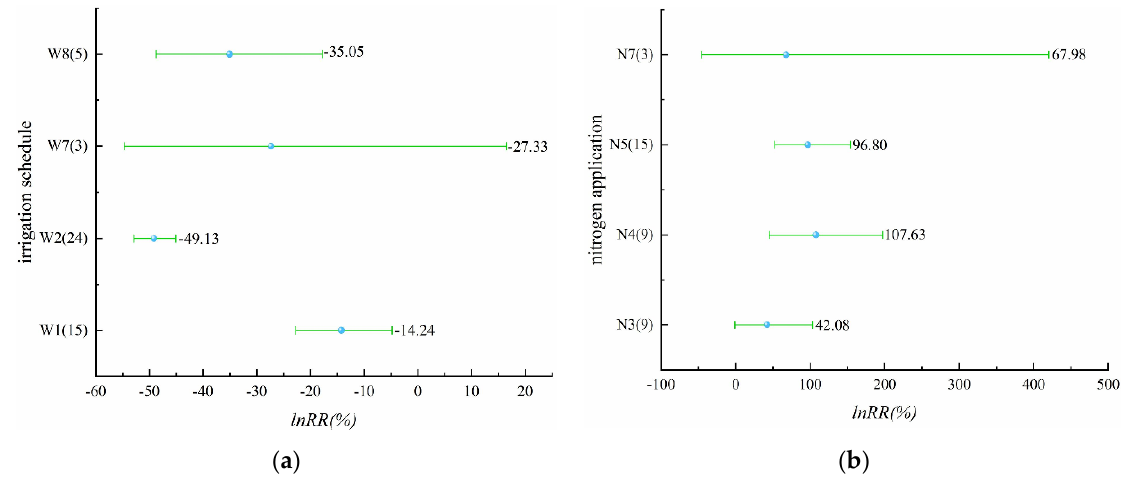
Figure 8. ( a ) Effect of different irrigation schedules on nitrogen leaching ( p = 0.00000); ( b ) effect of different nitrogen application levels on nitrogen leaching ( p = 0.44466).